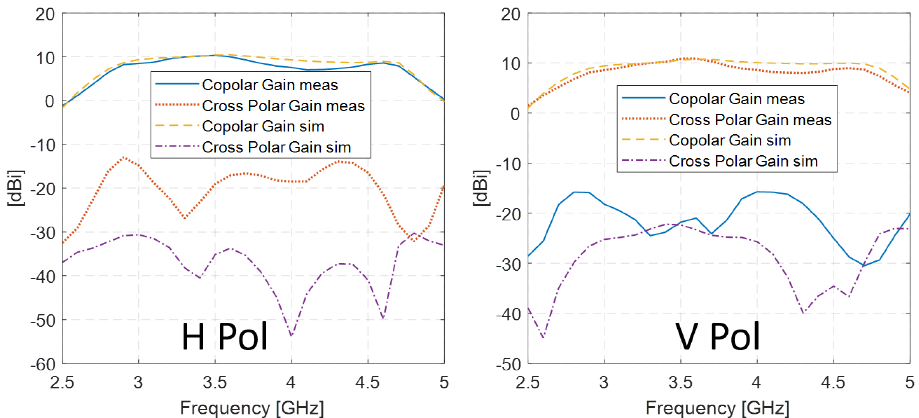
Figure 10. Scaled prototype: comparison between measurement and simulation in term of co-polar and dross-polar gain for both H/V polarizations.